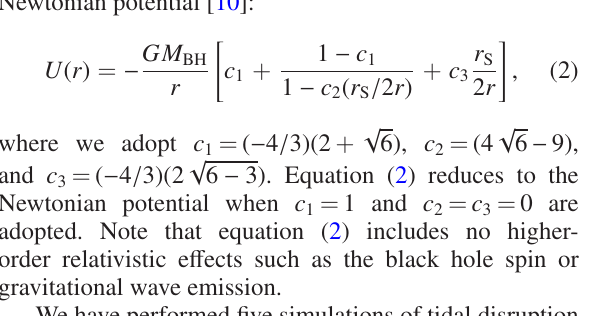
Figure 1 show di ff erential mass distributions and their corresponding mass fallback rates in Models 1-5. (a), the mass fallback rate is shown in panel (b). In panel (b), the horizontal solid line denotes the